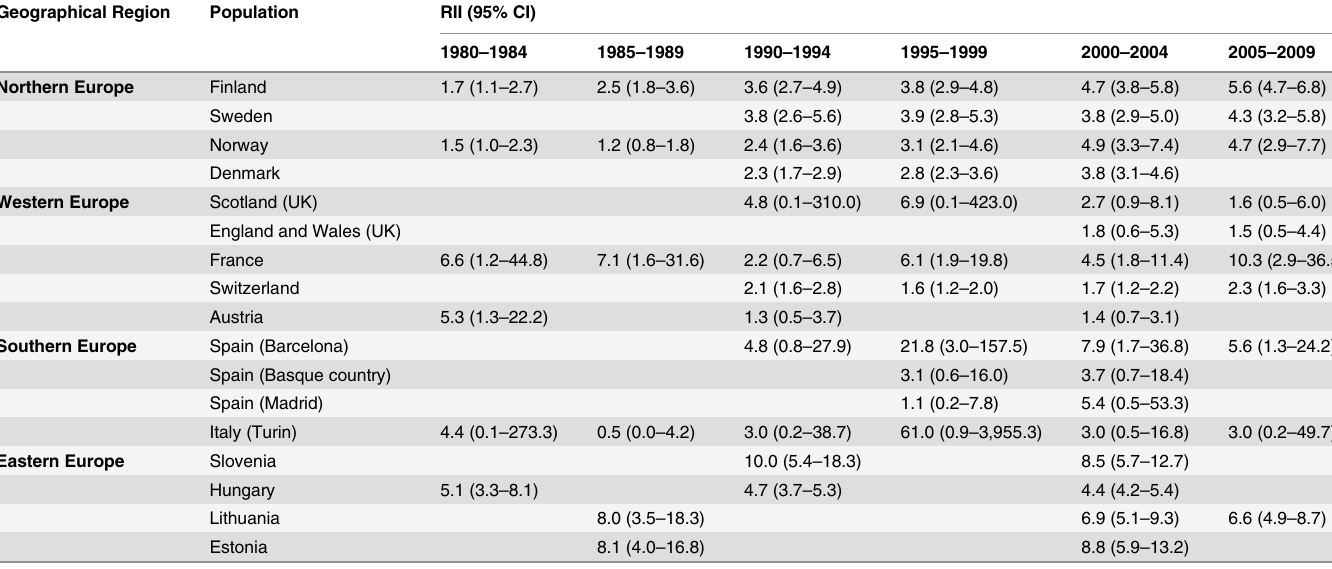
Table 7. Trends in RII for educational inequality in mortality from alcohol-related causes among women aged 55 – 79 y, ca. 1980 – 2010, by population. Geographical Region